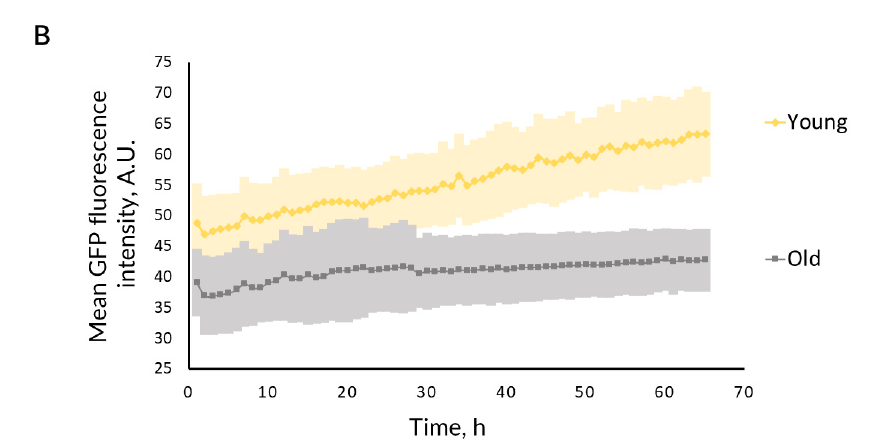
Figure 3. Proliferation of GFP-positive cells in the RTC cultures from young and old nestin-GFP mice. ( A ) Representative confocal images of GFP fluorescence in RTCs at the 2nd, 3rd, and 4th day of cultivation ( n = 3). ( B ) Dynamics of total GFP fluorescence intensity in the wells with RTC during the expansion of the cultures (mean ± SD; n = 3).